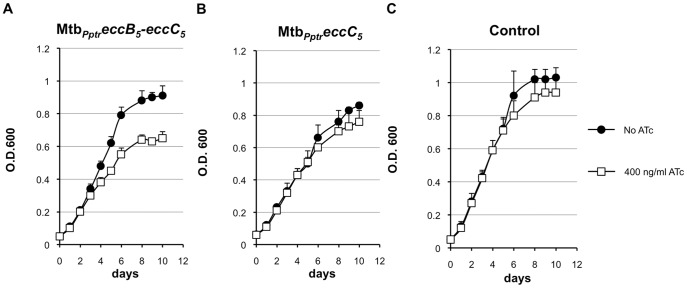
Growth of MtbPptreccB5-eccC5 and MtbPptreccC5 mutants in liquid medium.MtbPptreccB5-eccC5 (A), MtbPptreccC5 (B) and M. tuberculosis control strain (Mtb::tetR-pip) (C) were grown in Middlebrook 7H9 medium with or without 400 ng/ml ATc. Bacterial growth was monitored by daily measurements of OD600. The figure shows the mean and the standard deviations of OD600 values/measurements obtained in three independent experiments.